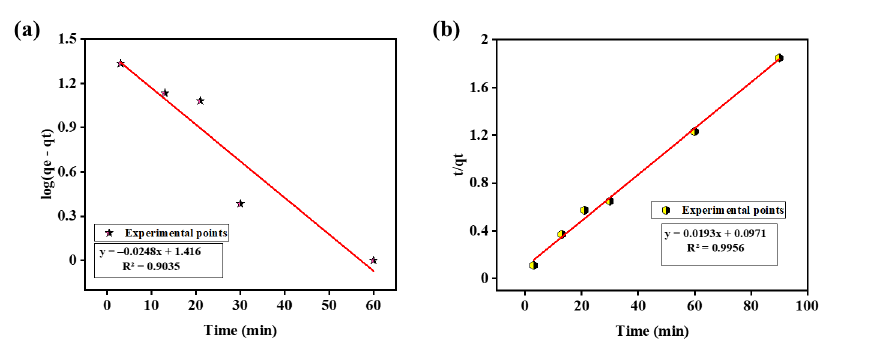
Figure 9. The plots showing Kinetic adsorption of lead (II) by Fe 3 O 4 (a) Pseudo first order, (b) Pseudo second